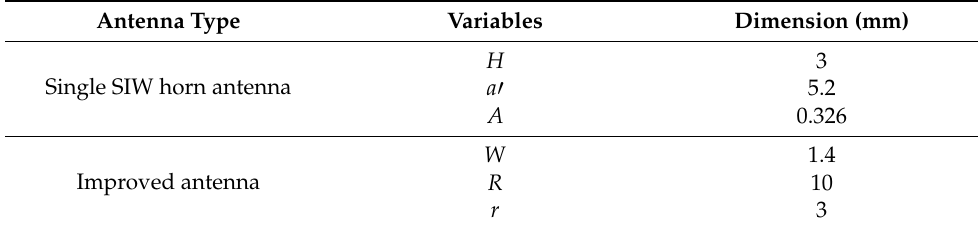
Table 2. Parameter optimization table.